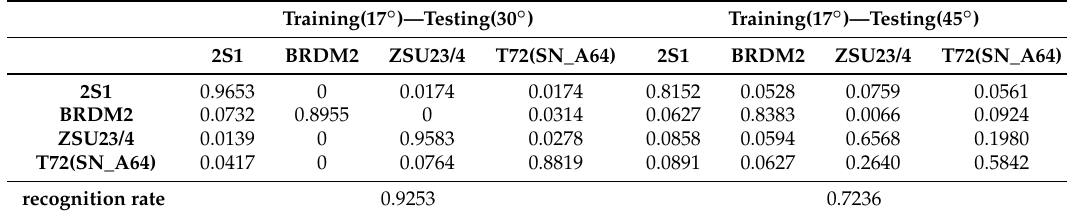
Table 18. The result of kNN based on SAR-HOG under